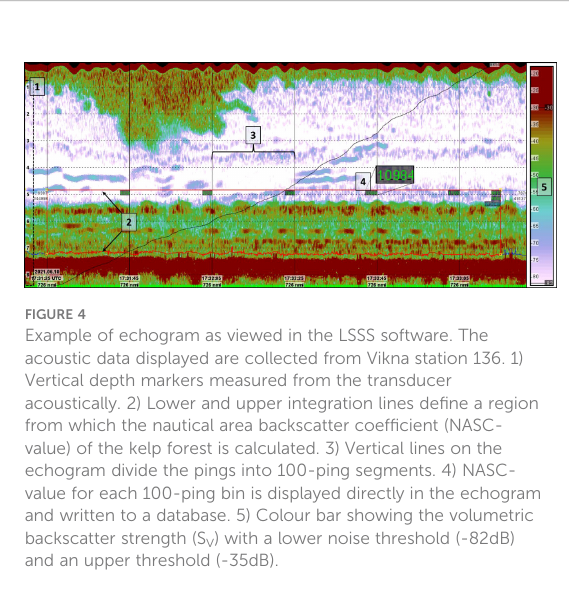
spikes and generated bottom detections on the echograms. The lower integration line was set by the aid of the bottom detection algorithm where possible, usually for stations below